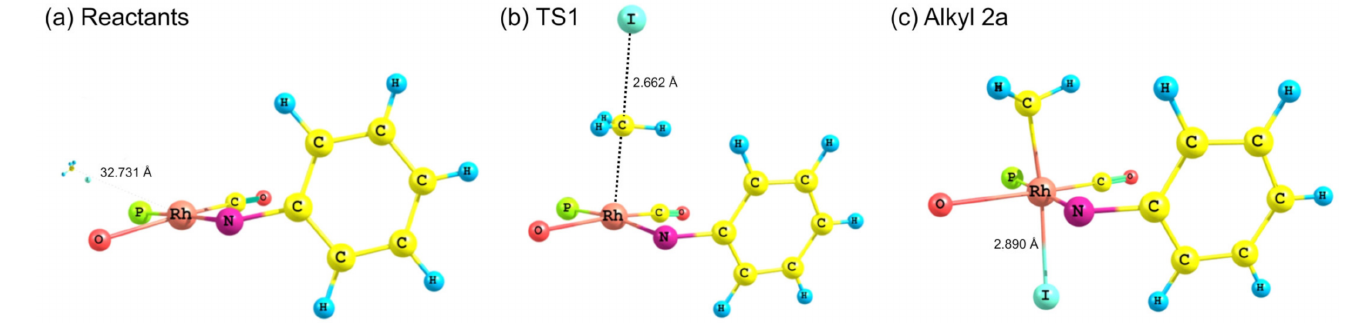
Figure 8. ( a ) DFT-calculated optimized geometries of the [Rh(CH 3 COCHCNPhCH 3 )(CO)(PPh 3 )] 3B complex (isomer O- trans -CO) and CH 3 I, with a large separation between the reactant molecules, referred to as reactants. ( b ) DFT-calculated transition state of the linear oxidative addition reaction between the [Rh(CH 3 COCHCNPhCH 3 )(CO)(PPh 3 )] 3B and CH 3 I. Referred to as TS1. The bonds, associated with the imaginary frequency of the transition state, are indicated with black dotted lines. ( c ) DFT-calculated optimized geometry of the Rh(III)-alkyl 2a product, referred to as Alkyl 2a. The three Ph groups of the PPh 3 ligand and CH 3 CCHCCH 3 backbone of [CH 3 COCHCNPhCH 3 ] ligand are excluded for